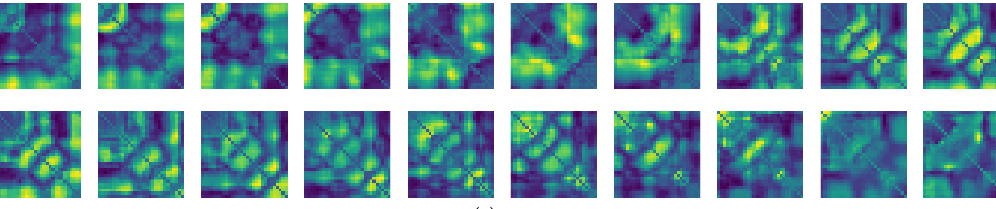
Figure 12. Some samples for walking motion: ( a ) predicted results of the FNO model, ( b ) target recurrence plot data, and ( c ) predicted results of the CNN model.